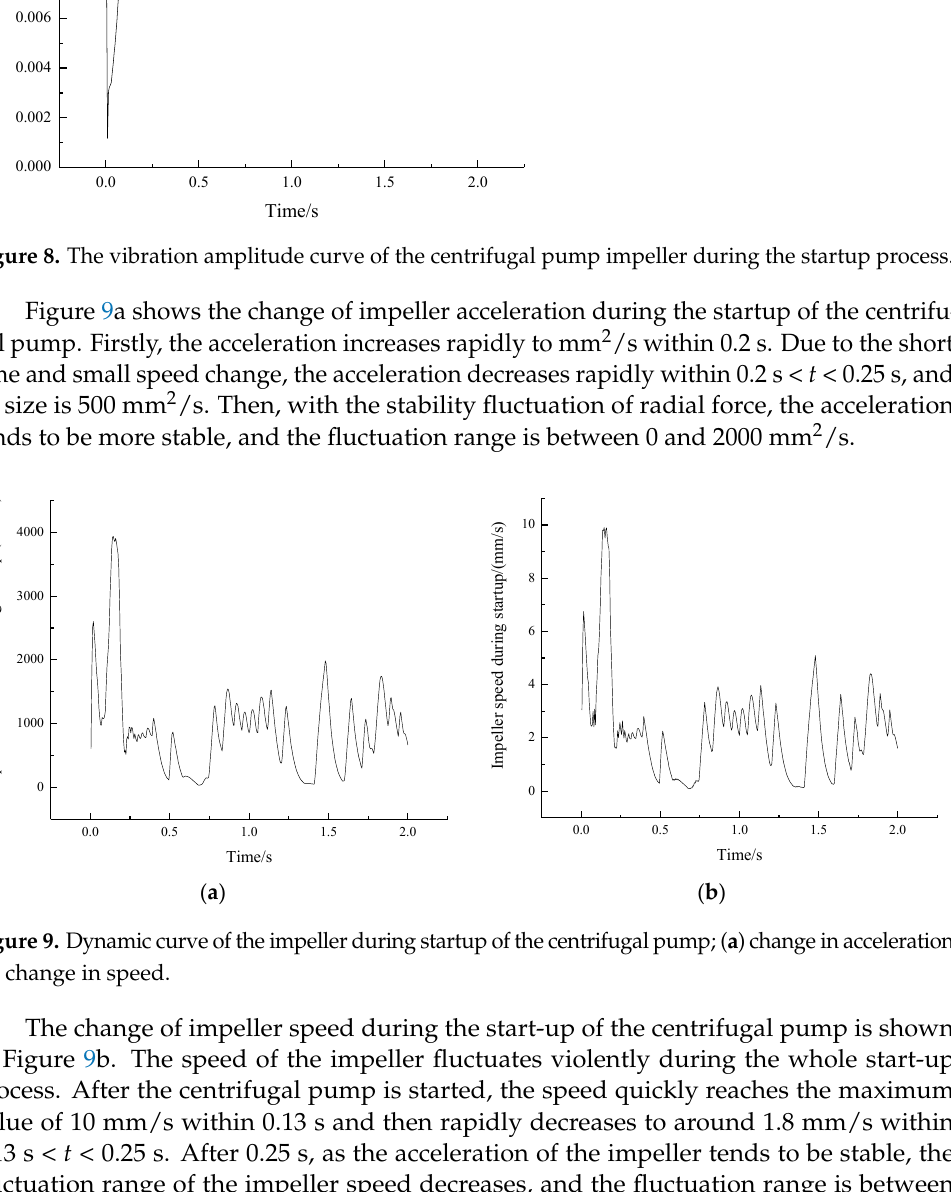
Figure 8. The vibration amplitude curve of the centrifugal pump impeller during the startup pro- cess.